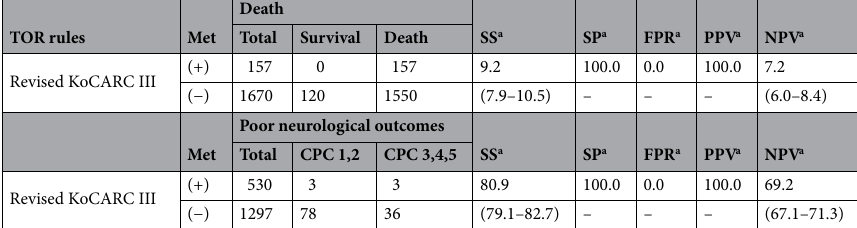
Table 5. Predictive performance of revised KoCARC TOR rule for death and poor neurological outcomes at hospital discharge. TOR, termination of resuscitation; SS, sensitivity; SP, specificity; FPR, false-positive rate; PPV, positive predictive value; NPV, negative predictive value; BLS, basic life support; KoCARC, Korean Cardiac Arrest Research Consortium; CPC, cerebral performance category. CPC 1 and 2 were defined as favorable neurological outcomes, and CPC 3, 4, and 5 as poor neurological outcomes. a Variables are presented as the number and 95% confidence